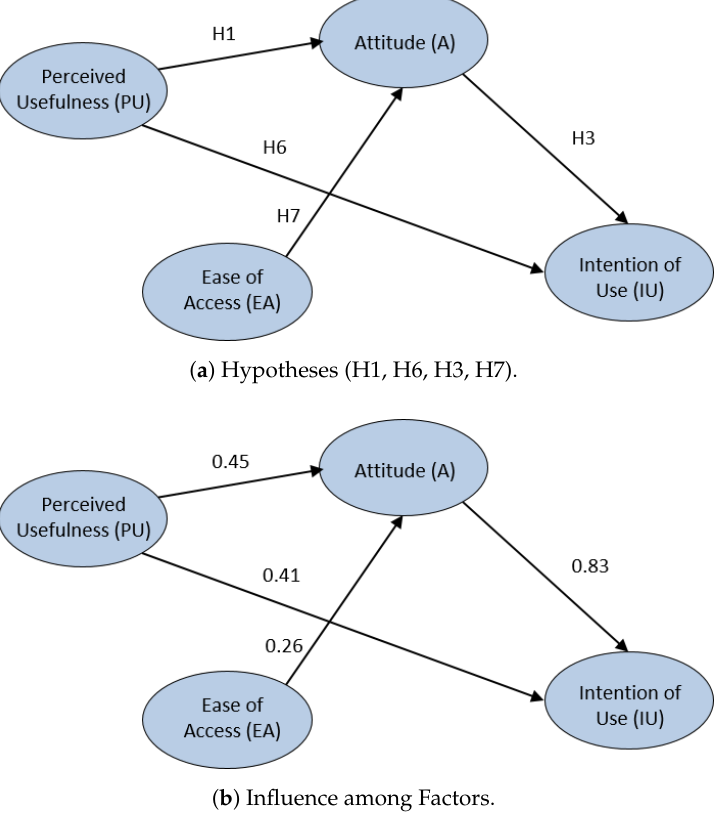
Figure 13. Proposed Improved UTAUT Model for the